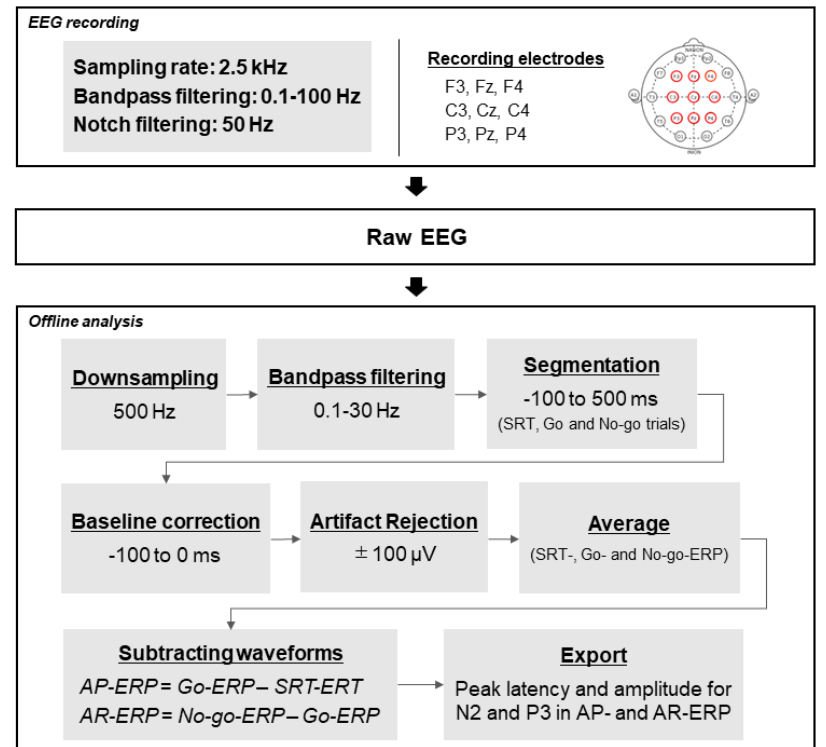
Figure 3. The flowchart for pre-process and analysis. AP, action postponing; AR, action restraint; ERP, event-related potential.